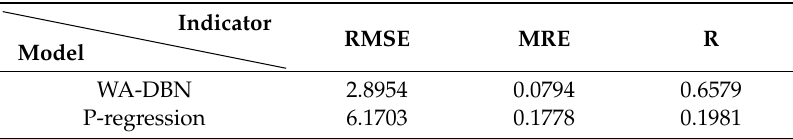
Figure 6. Comparative results of STII prediction between WA-DBN and P-regression. Table 3. Error analysis of WA-DBN and P-regression.